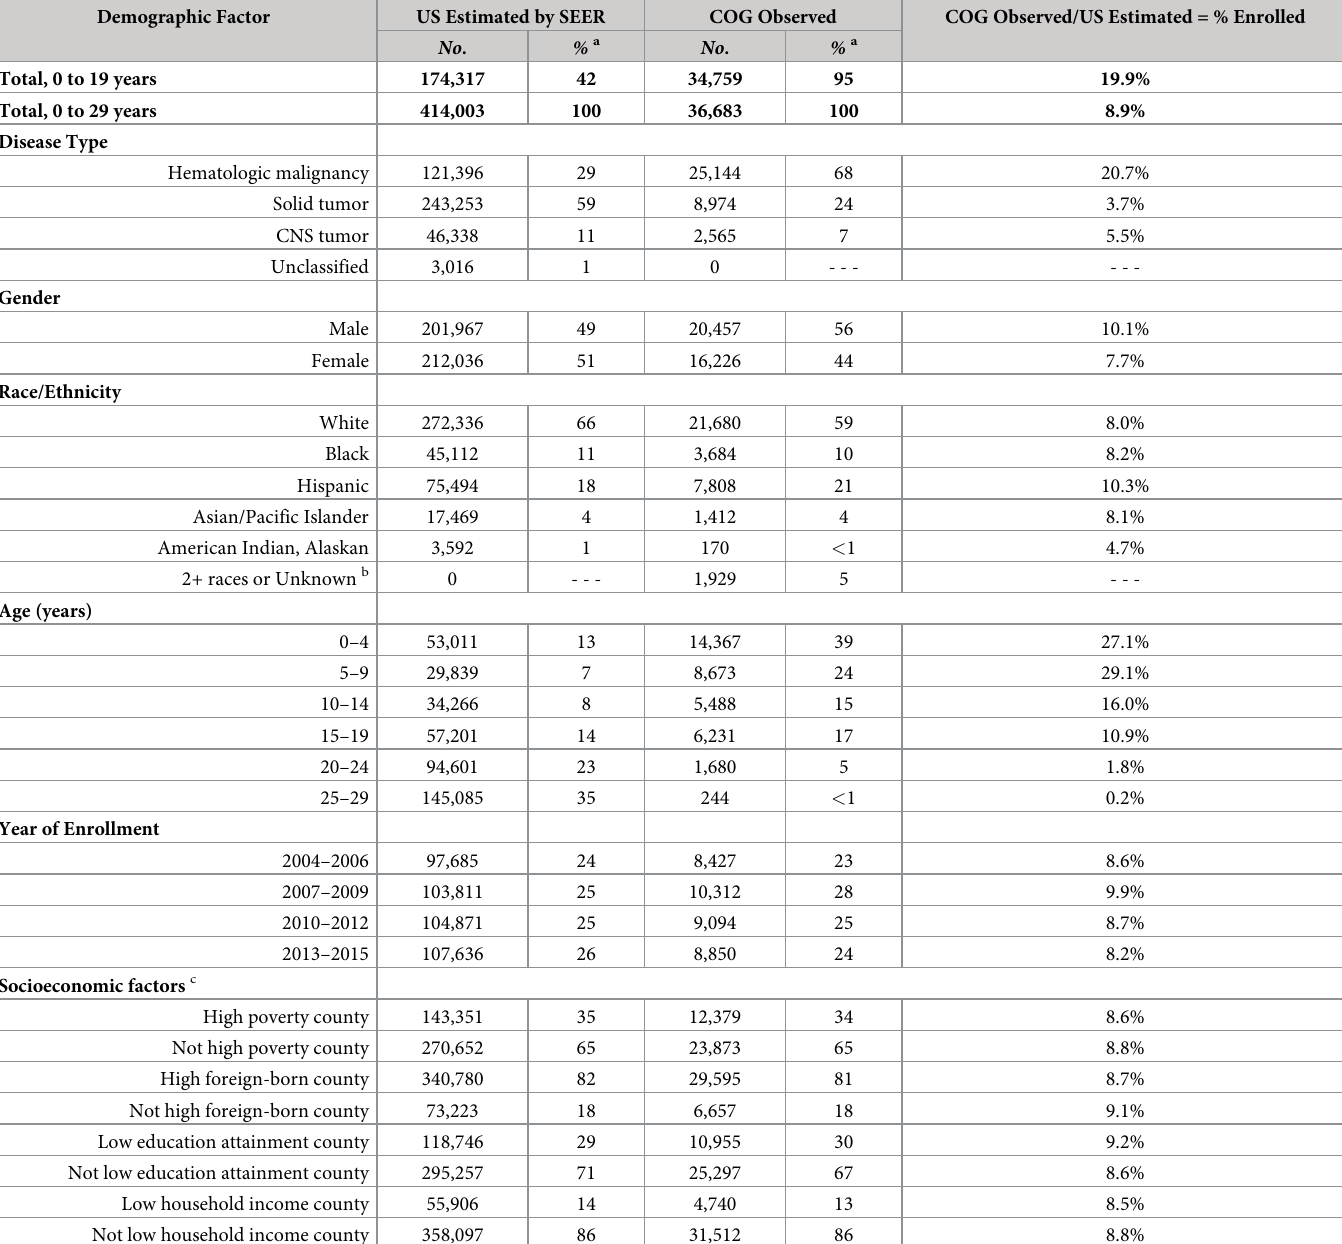
Table 1. Estimated US cancer cases by SEER and observed COG enrollment,